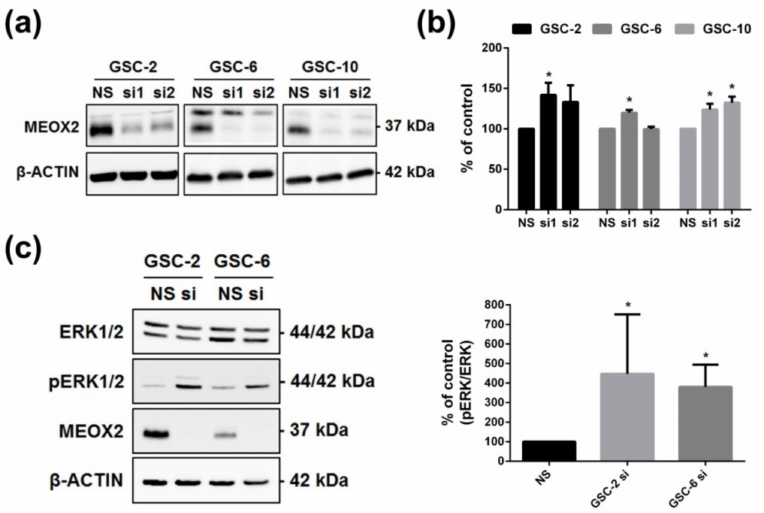
Figure 3. Proliferative effect of MEOX2 through the ERK/MAPK pathway. ( a ) Western blot validation of MEOX2 siRNA inhibition; ( b ) Analysis of GSC-2, -6, and -10 viability using two siRNA, 5 days after inhibition of MEOX2 expression ( n = 4, p < 0.05, Mann–Whitney test); ( c ) Representative WB and histograms representing the variation of pERK/ERK after inhibition of MEOX2 (siRNA1) for 48 h in GSC-2 and -6 ( n = 4, * p < 0.05, Mann–Whitney